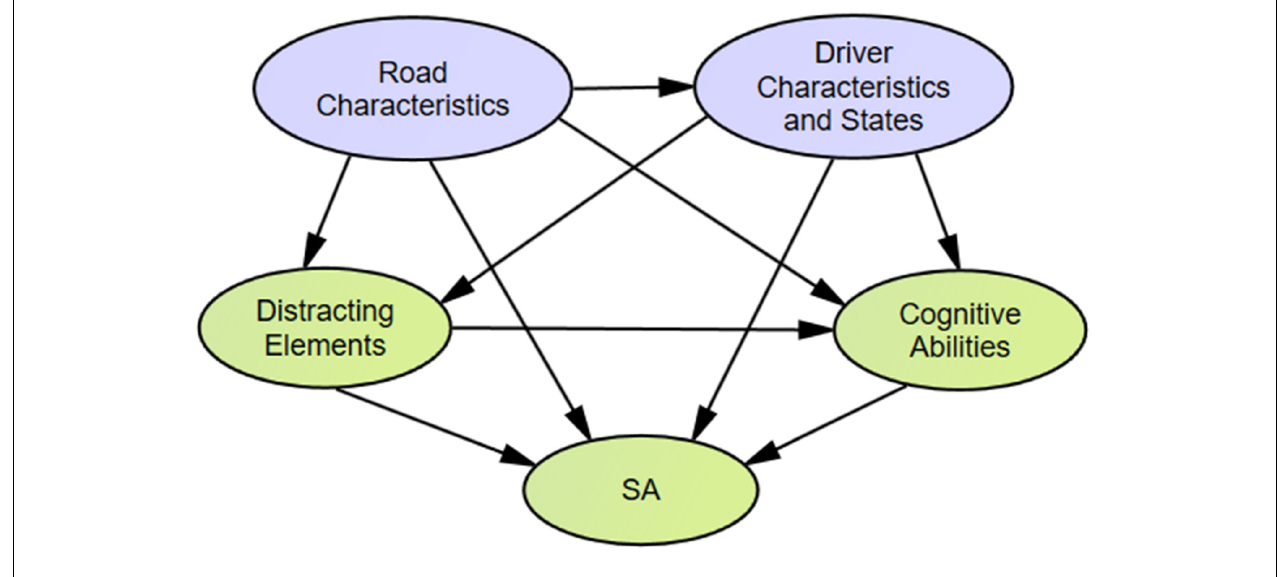
FIGURE 2 | Hypothesis of structural sub-model.